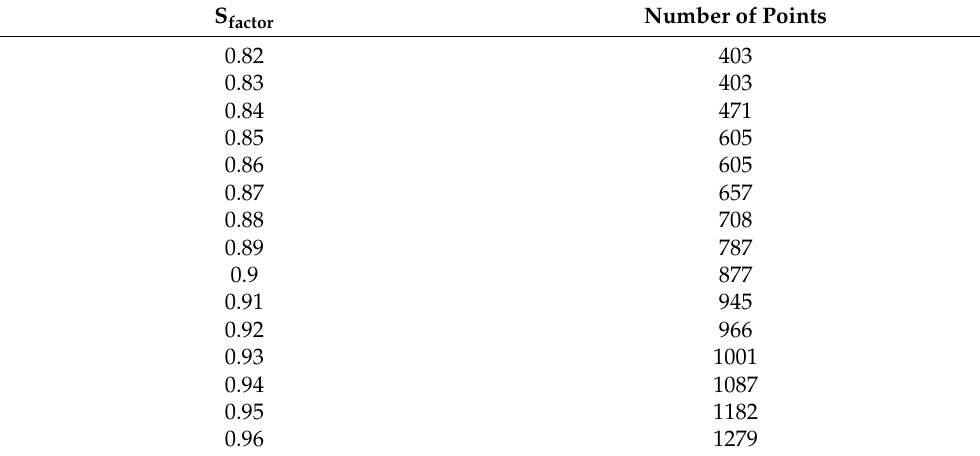
Table 1. Number of points detected for each S factor .